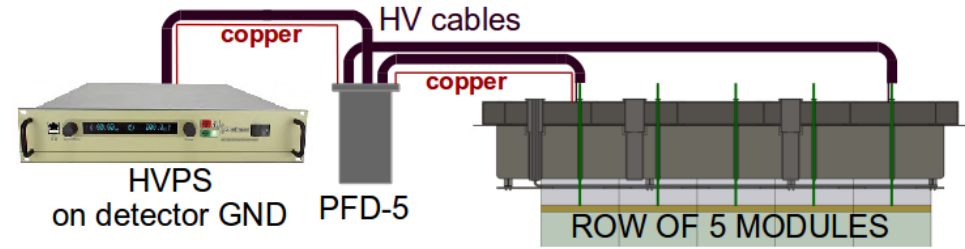
Figure 11. Electrical schematics of the HV system. Safety ground braid is highlighted in red. The PFD-5 is an oil-filled high voltage low-pass filter with one input and five inde- pendent outputs as seen on the left side of Figure 12. Each output is equipped with a voltage divider. The output values are digitized with a dedicated controller via Ethernet. In addition, the oil temperature is